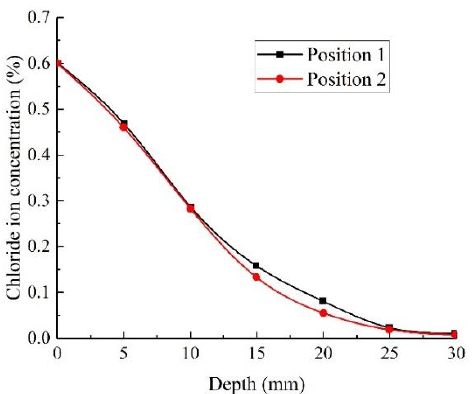
Figure 17. Chloride ion concentration of specimen HPC50 with different aggregate distribution.